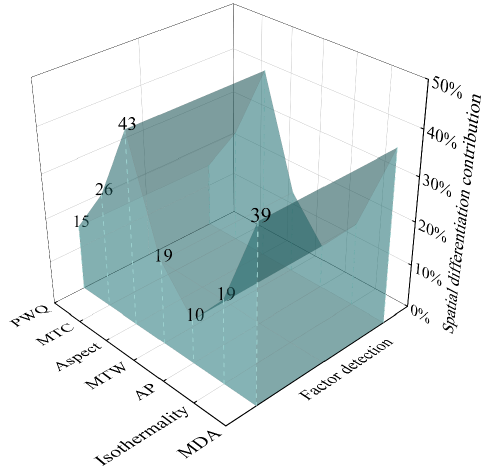
Figure 8. Contribution of Driving Forces to Spatial Heterogeneity.